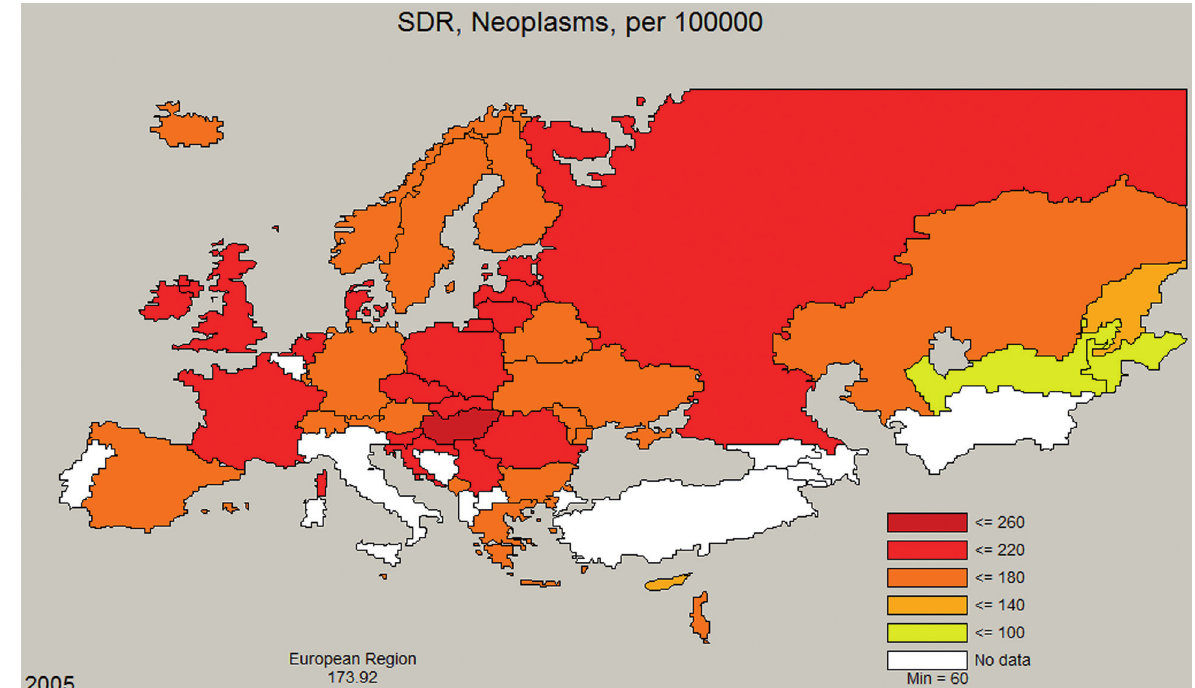
Fig. 3. Neoplasm mortality in 2005 (WHO/Europe EMDB 2011).